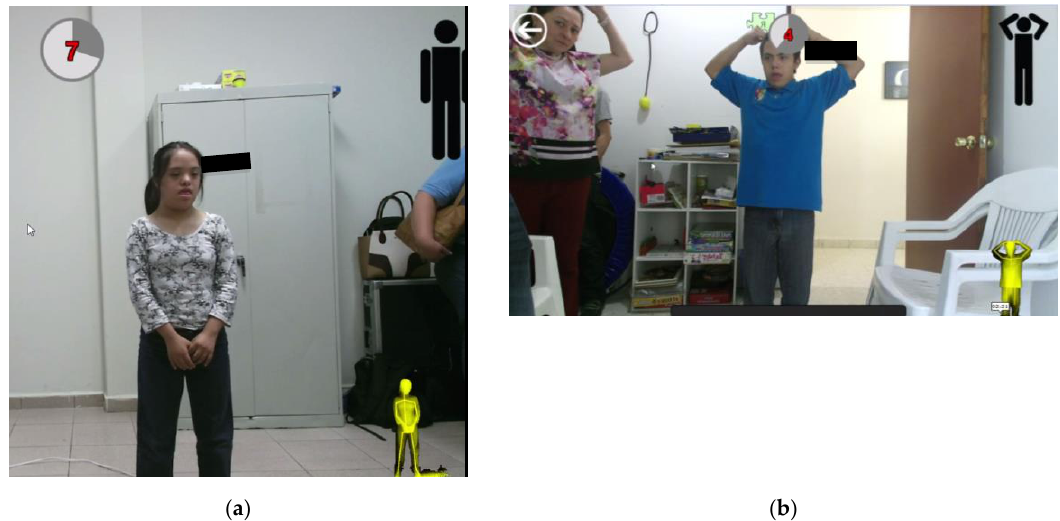
Figure 6. ( a ) Participant attempting to perform a gesture (1); ( b ) moderator demonstrating gesture to a participant.